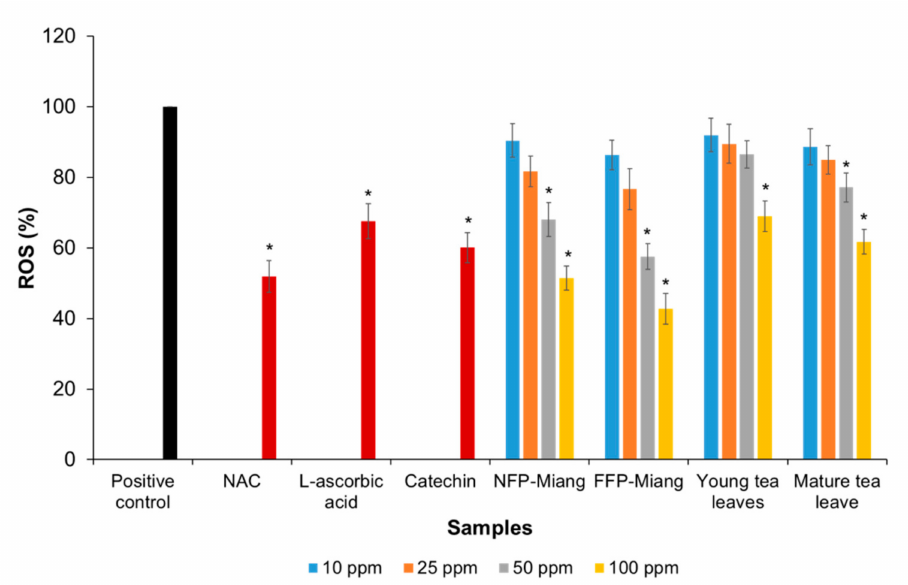
Figure 5. Percentage inhibition of various Miang extract concentrations toward intracellular reactive oxygen species (ROS) production in HT-29 colorectal cells induced by hydrogen peroxide using N-acetylcysteine (NAC, 50 µ M), L-ascorbic acid (250 µ M), and catechin (125 µ M) as positive controls. Different asterisks (*) represent significant differences in group percentages at p < 0.05 vs. the positive